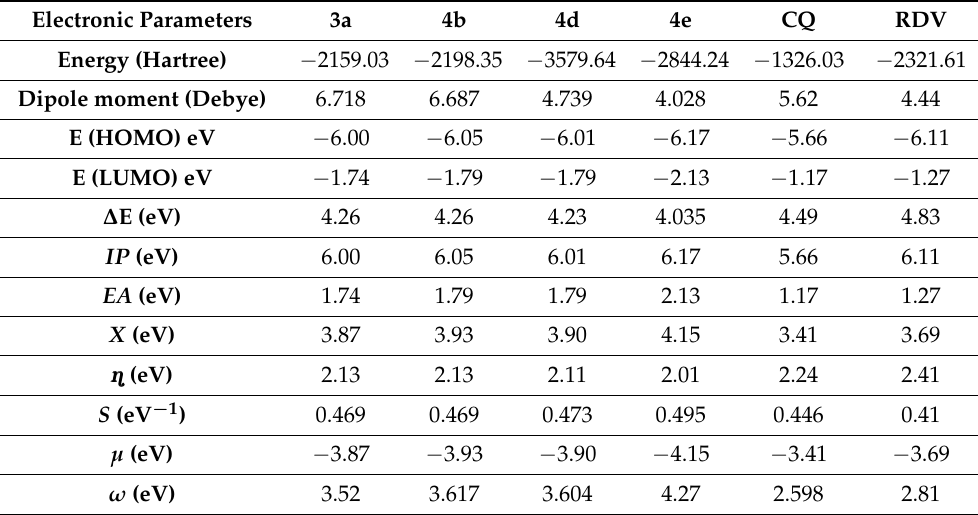
Table 5. Energy descriptors of the most active derivatives 3a , 4b , 4d , 4e and positive controls (chloroquine and remdesivir) calculated using DFT